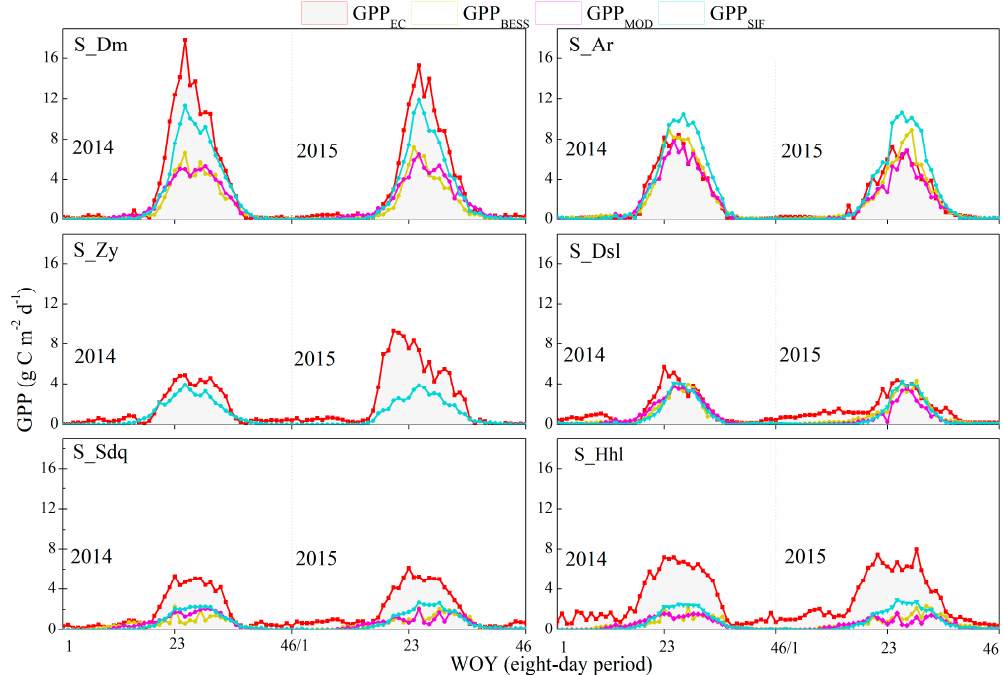
Figure 3. Seasonal dynamics of the GPP from flux measurements (GPP EC ) and the estimates from the BESS products (GPP BESS ), the MODIS (GPP MOD ), and the GOSIF (GPP SIF ) at the six flux sites between 2014 and 2015. Note: The values extracted from both MODIS and BESS products were null at the Zhangye wetland site (S_Zy).